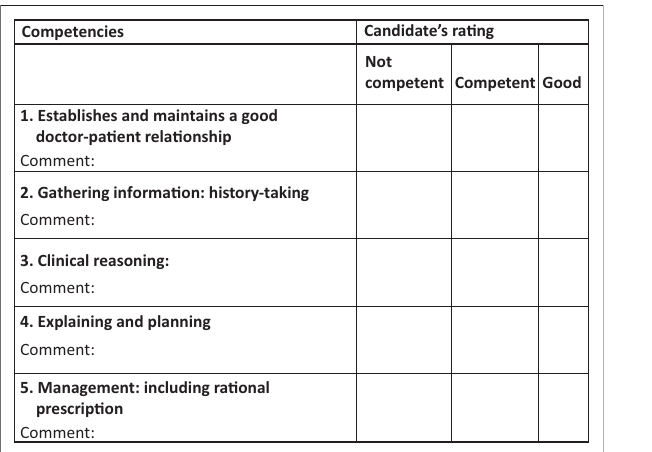
FIGURE 3: Marking sheet for objectively structured clinical examination station